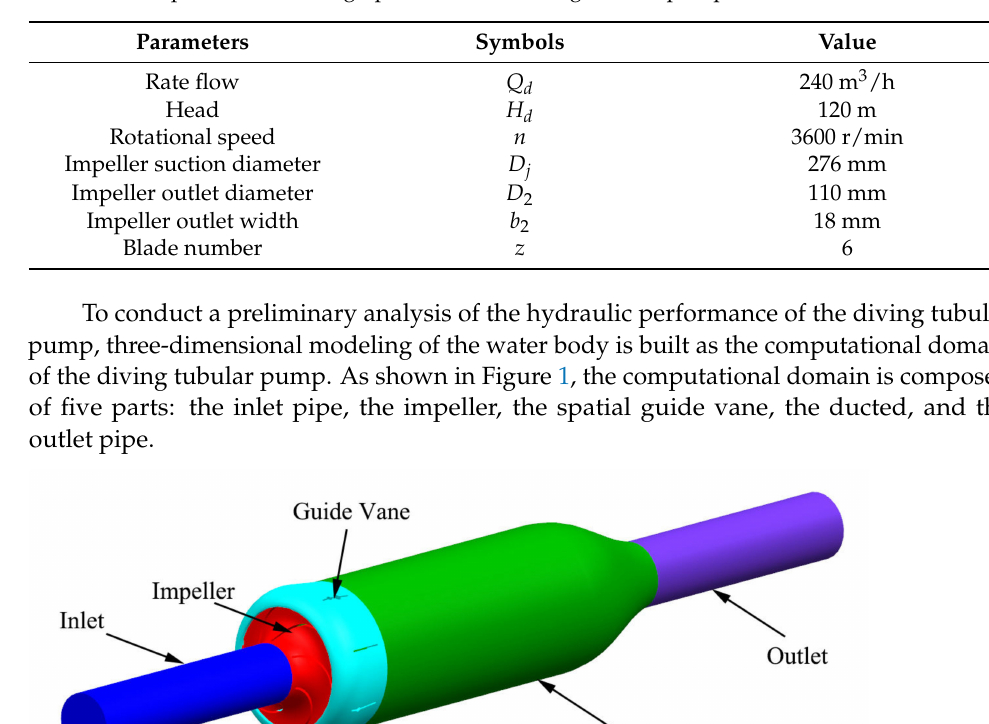
Table 1. Main performance design parameters of diving tubular pumps.